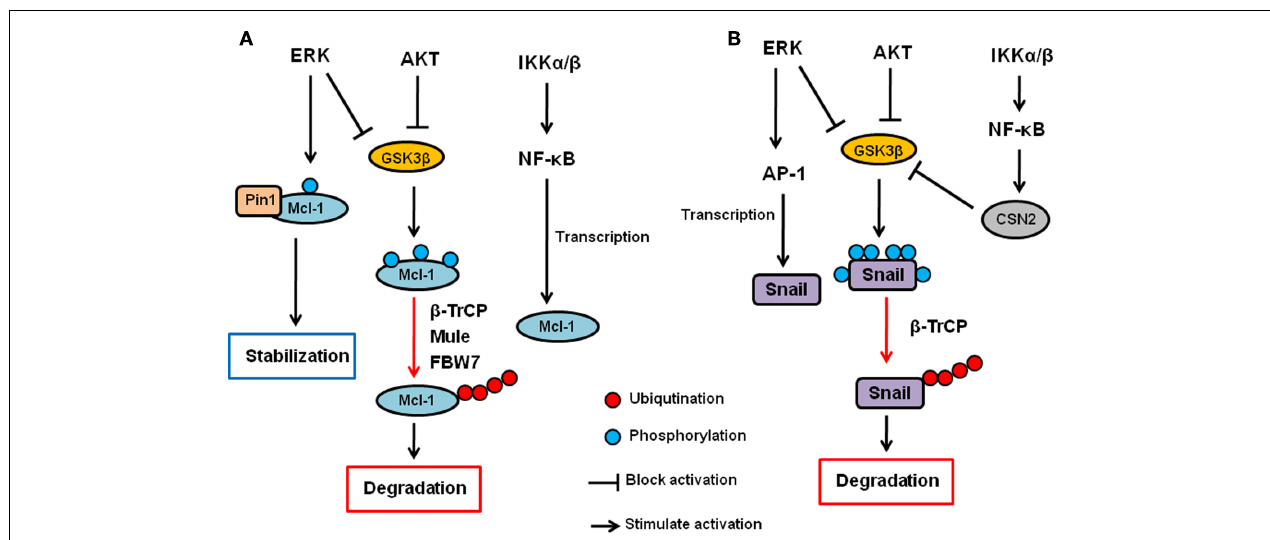
but the mechanisms are uncertain. (B) AKT and ERK phosphorylates GSK3 β and inhibit it. GSK3 β phosphorylates Snail and induces its nuclear exclusion, ubiquitination and subsequent degradation via β -TrCP. ERK also upregulates Snail transcription via AP-1 transcription factor.The IKK–NF- κ B pathway inhibits Snail via upregulation of CSN2, which interferes with the GSK3–Snail interaction and ubiquitination of